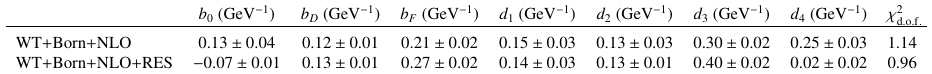
Table 1. Values of the NLO parameters and the corresponding χ 2